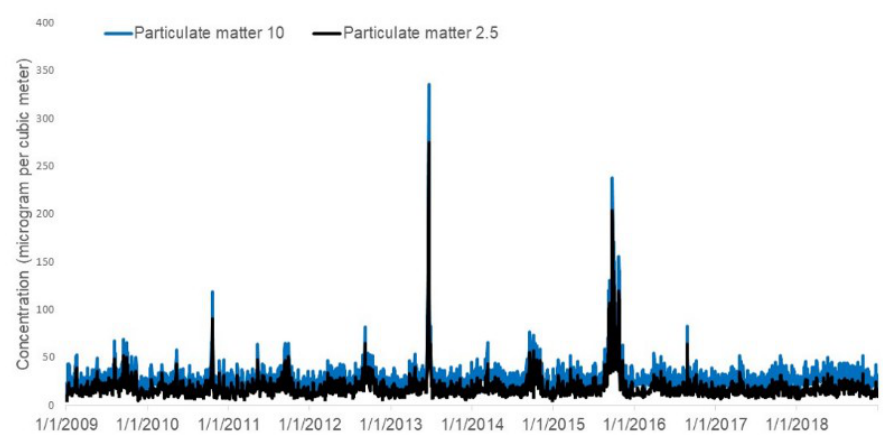
Figure 2. Daily distribution of particulate matter (PM 2.5 and PM 10 from 2009 to 2018.